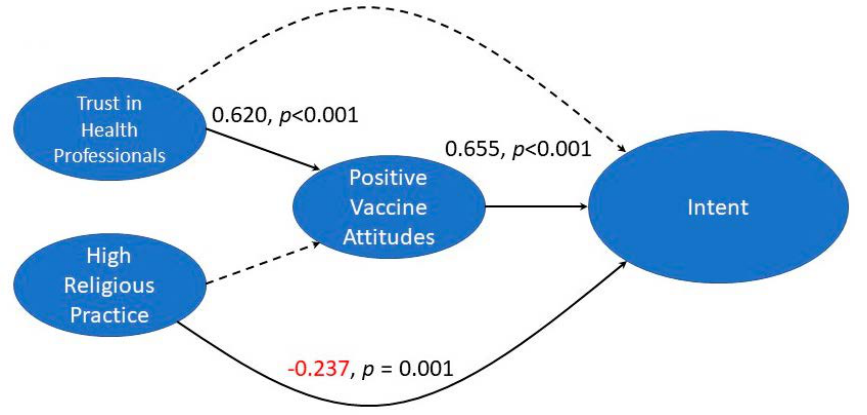
Figure 4. Trust in medical professionals is predictive of intent to vaccinate by means of increased trust in vaccines in general: The Latent variables “Trust in Health Professionals”, “High religious practice”, “Positive vaccine attitudes”, and “Intent to vaccinate” were combined in a structural model. Trust in health professionals leads to more positive vaccine attitudes, which increased intent to vaccinate. High religious practice does not affect general vaccine attitudes, but it does have a direct negative impact on intent to vaccinate against HPV. Values shown are beta coefficients. Value in red shows negative correlation.